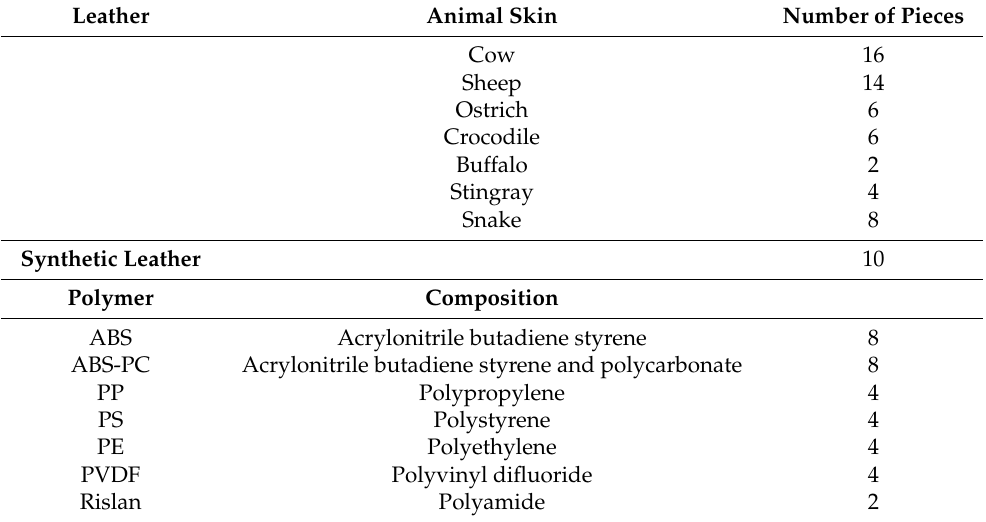
Table 1. Samples tested in this work. All samples, including polymers, leather, and synthetic leather had different